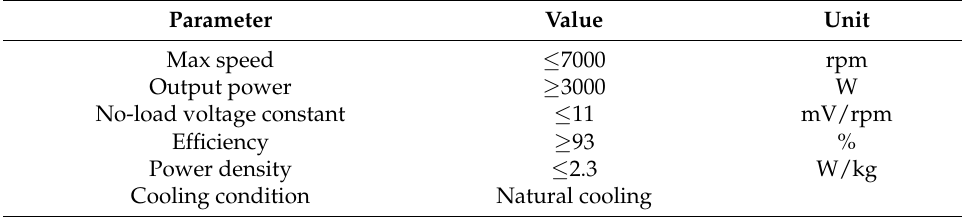
Table 1. Design specifications for AFPM generator.